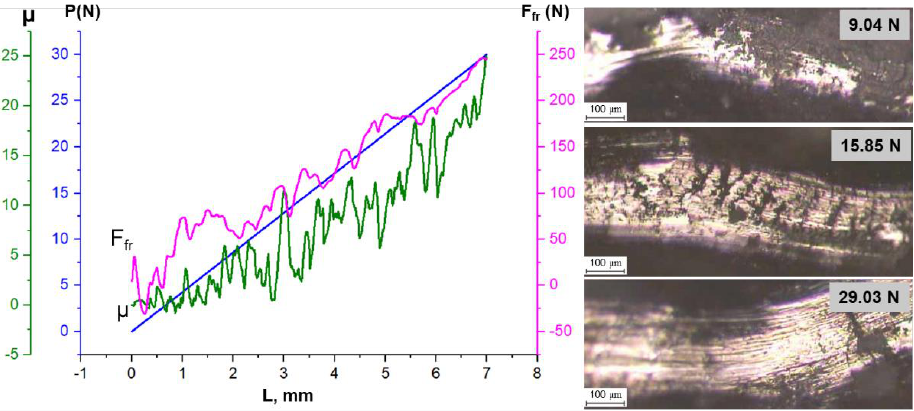
Figure 13. Measurement of the friction force F fr and friction coefficient µ increased the load applied to the indenter during scratching of a six-layer coating.